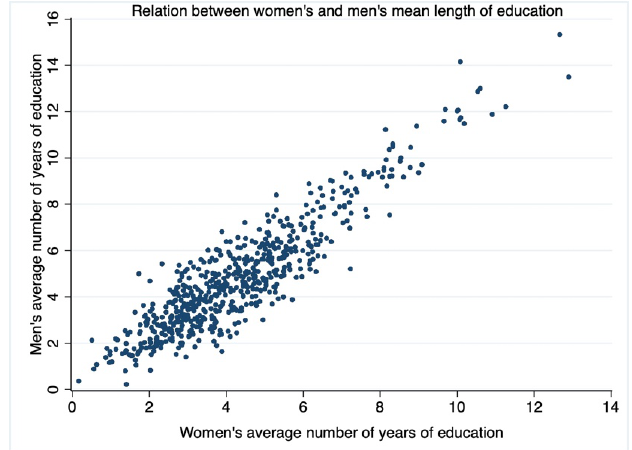
Figure 3 – Relation between women’s and men’s mean length of education at the cluster level (correlation = 0.891). Source: Bangladesh Demographic and Health Survey